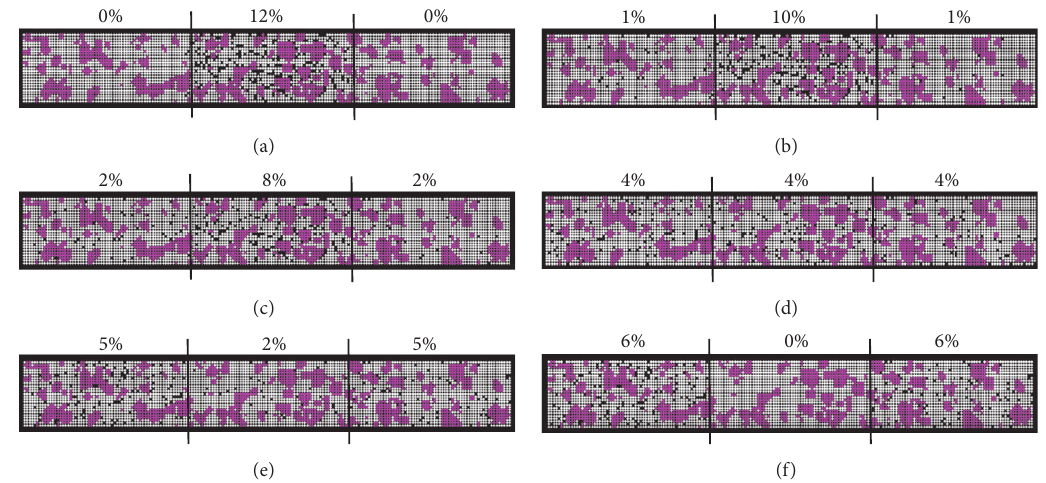
Figure 10: Horizontal distribution of air voids: (f) H-0/12/0; (e) H-1/10/1; (d) H-2/8/2; (c) H-4/4/4; (b) H-5/2/5; (a) H-6/0/6.